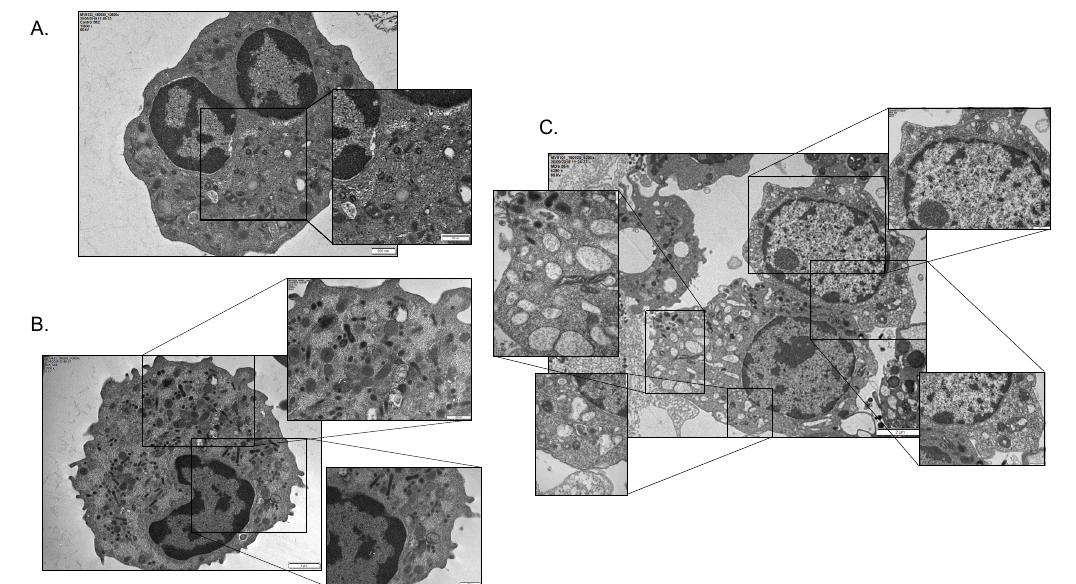
Figure 4. Electron microscopy of the differentiating myeloid lineage following whole bone marrow aspirate ficoll bilayer separation (high-density layer) from MDS patients (n = 4) and controls (n = 2). ( A ) Control, ( B ) MDS (<5% blasts), ( C ) MDS ( ≥ 5% blasts). ( A ) Mature healthy neutrophil with numerous small healthy mitochondria (outlined in the black panel). ( B ) Mature myeloid lineage with complete mitochondrial absence while with the presence of double membrane autophagosomes at variable maturation stages. ( C ) Markedly atypical maturing myeloid lineage without granules with nuclear immaturity. An abundance of large, elongated mitochondria and numerous maturing autophagosomes, some with engulfed mitochondria, is also evident. Scale bars and magnifications are shown on the upper left corner of each picture.